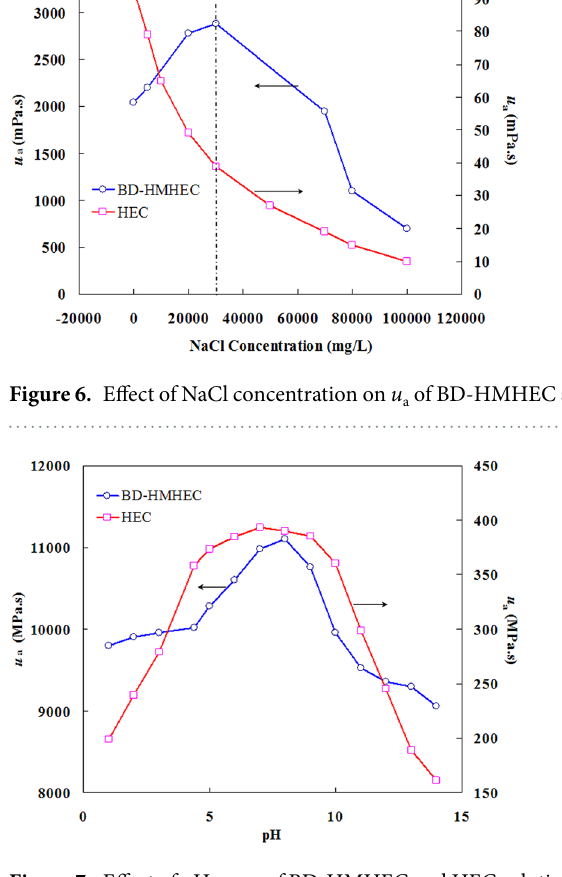
Figure 7. Effect of pH on u a of BD-HMHEC and HEC